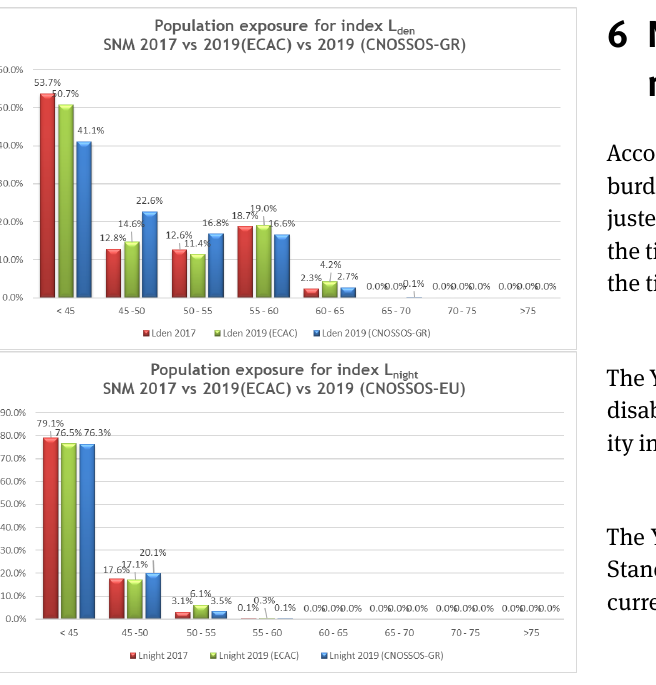
Figure 8: Population exposure for indexes L den & L